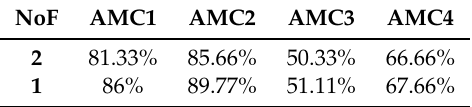
Table 8. Effect of PCA-based feature selection on the proposed MLP using HLN = 30 for AMC